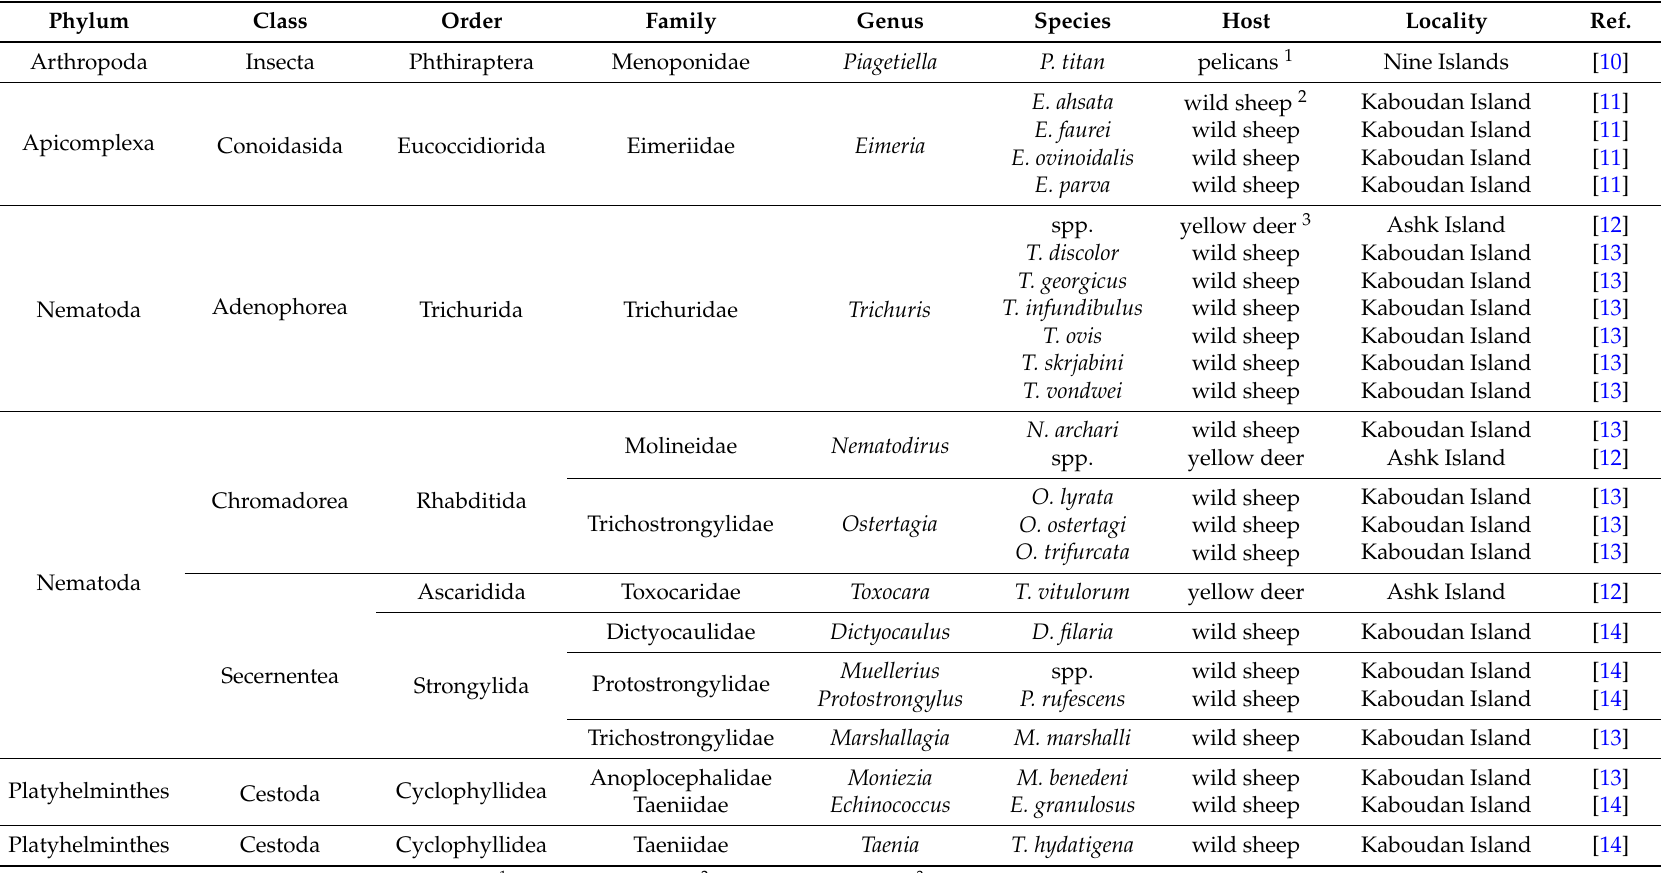
Table 5. List of reported parasites at pelicans and some mammalians from the National Park of Urmia